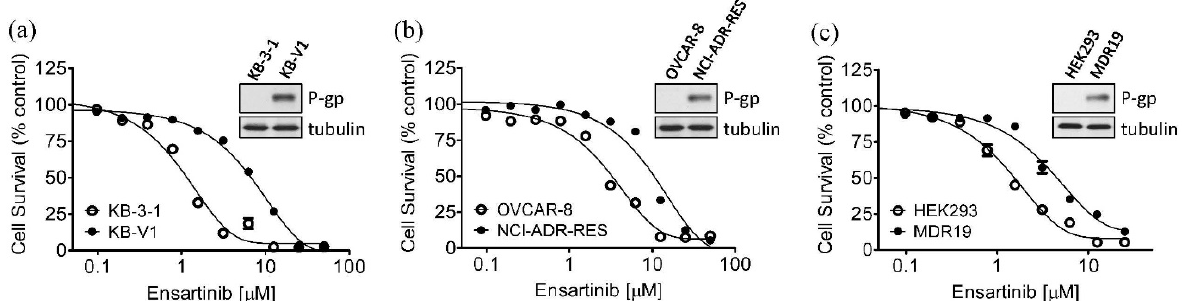
(Figure 1b) as compared to the parental KB-3-1 and OVCAR-8 cancer cell lines. In contrast, ensartinib was equally cytotoxic to the ABCG2-overexpressing human S1-MI-80 colon cancer cells and the ABCG2-overexpressing H460-MX20 human non-small-cell lung cancer (NSCLC) cells as to the parental S1 and NCI-H460 cancer cells (Table 1). The cytotoxicity of ensartinib was also examined using HEK293 cells transfected with empty vector (pcDNA3.1- HEK293), P-gp (MDR19-HEK293) or ABCG2 (R482-HEK293). The fact that the MDR19- HEK293 cell line was three-fold more resistant to ensartinib (Figure 1c) is in agreement with our observation concerning P-gp-overexpressing cancer cell lines. Since our data suggested that ensartinib resistance was mediated by P-gp, the cytotoxicity of ensartinib was determined with or without 1 µ M tariquidar, a P-gp inhibitor. As shown in Table 1, tariquidar significantly reversed resistance to ensartinib in P-gp-overexpressing cell lines without affecting the parental cell lines, indicating that ensartinib was definitely a substrate for P-gp.